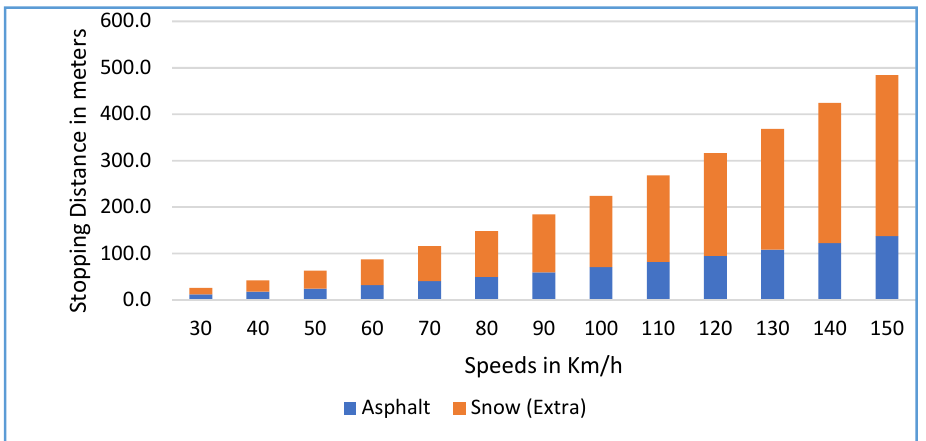
Figure 10. Extra stopping distance in meters on snow road compared to dry asphalt road for different speeds.